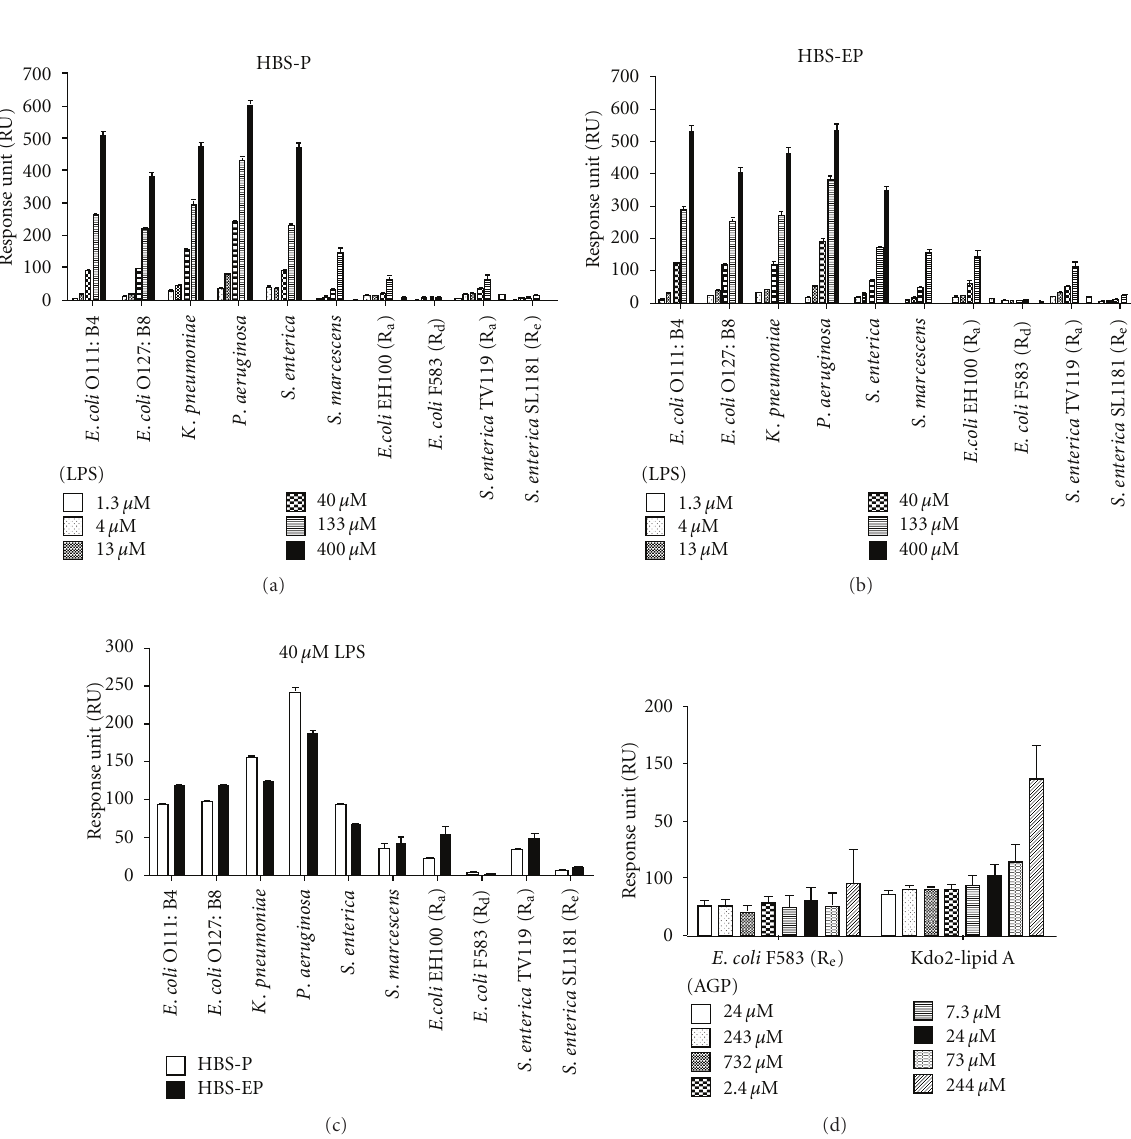
Figure 3: SPR assay of the binding of LPS or lipid A to AGP. (a) Binding responses over a concentration range of LPS in EDTA free (HBS- P) and (b) EDTA bu ff er (HBS-EP). (c) Binding responses at 40 μ MLPS in EDTA free (HBS-P) and EDTA bu ff er (HBS-EP). (d) Binding responses of AGP to DMPC bilayer incorporated 10 (mol/mol) % lipid